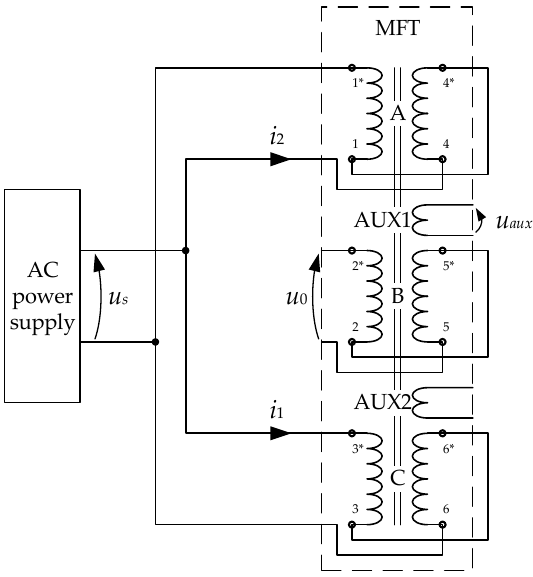
Figure 4. Circuit diagram of the equivalent B ( H ) measurement setup where the windings C and A are supplied.